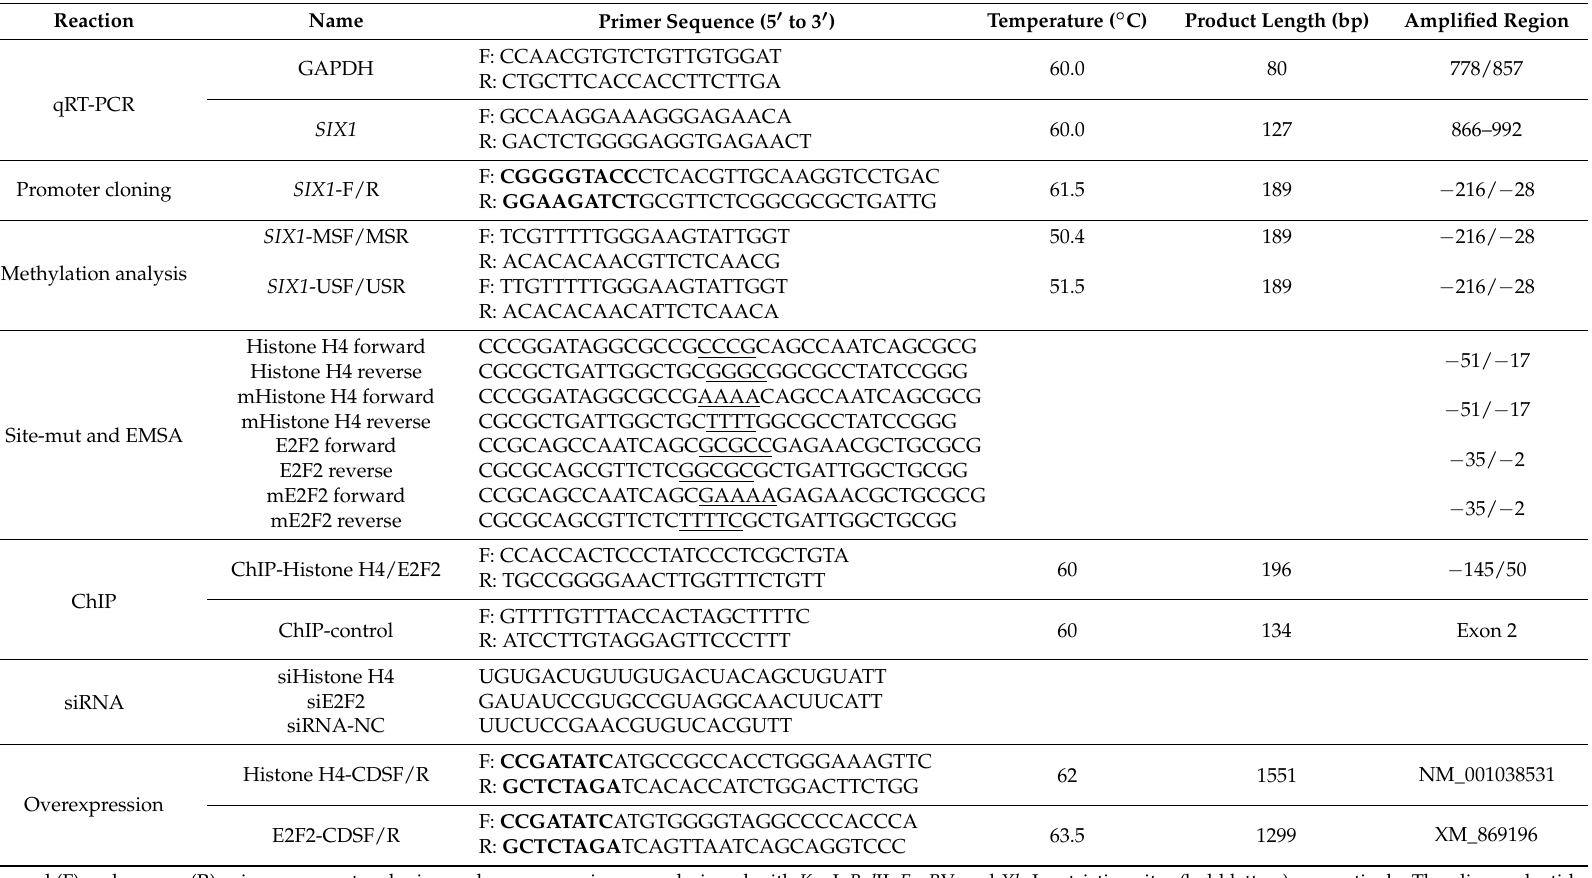
Table 1. Primers used in the expression and methylation analysis of the SIX1 promoter